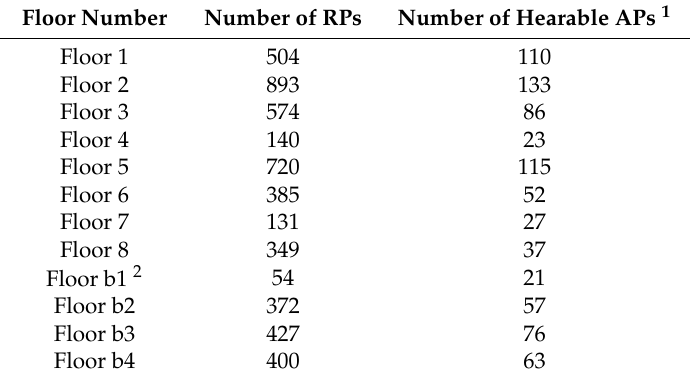
Table 2. Distribution of RPs and the number of APs at 12 floors in Test-bed 2.